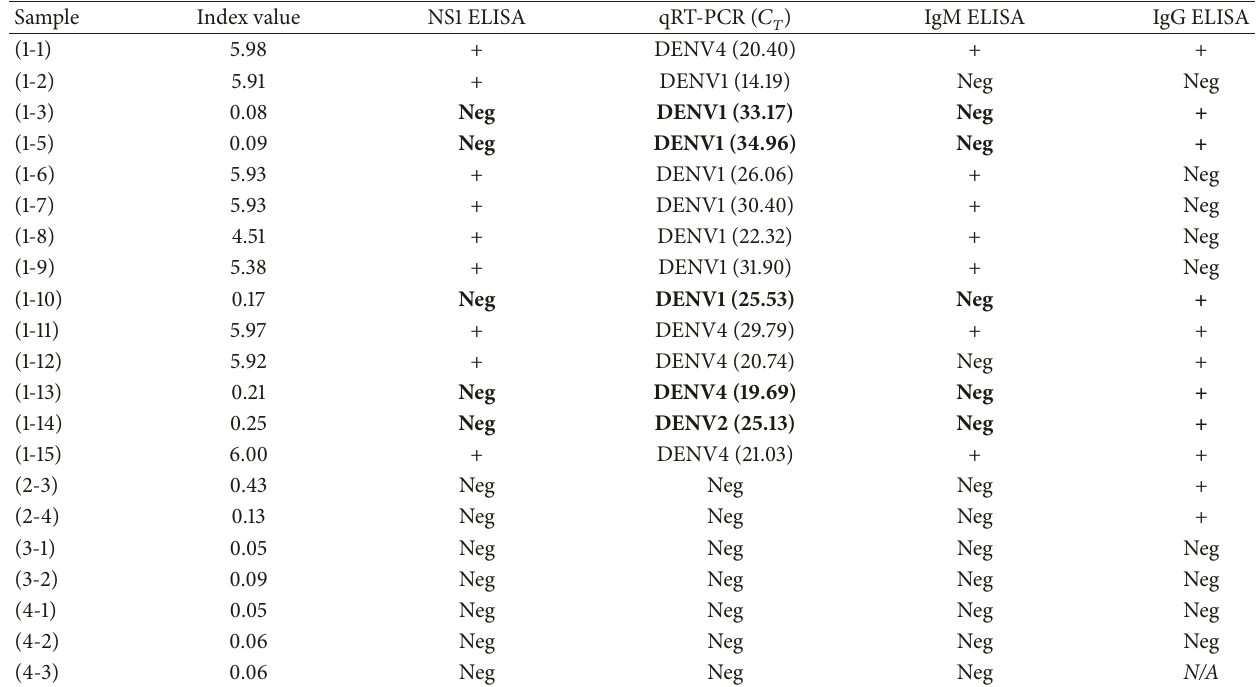
Table 1: DENV NS1 detection in selected serum samples as determined by ELISA and in comparison to clinical molecular (qRT-PCR) and serological (anti-DENV IgM and IgG) results. The table details the results of DENV NS1 detection by ELISA against qRT-PCR, IgM, and IgG DENV assays for a group of serum samples selected for inclusion and based on the following criteria: ( 1 ) denotes samples that were positive by qRT-PCR for DENV as determined by BOPHL-Tampa; ( 2 ) denotes samples that were positive for DENV by IgG detection only as determined by BOPHL-Tampa; ( 3 ) denotes samples that were DENV negative received by BOPHL-Tampa for all DENV-specific assays; ( 4 ) denotes samples that were collected from Martin County serosurvey and were found to be DENV negative by all DENV-specific assays. Index values represent the mean of duplicate values obtained when reading samples at 450 nm and taking calibrators into account. Negative samples had an index value of less than 0.9, those between 0.9 and 1.1 were equivocal, and those above 1.1 were positive for NS1 detection. Results are listed as either positive (+) or negative (neg) for each ELISA. Positive qRT-PCR results are reported either as neg or positive by listing serotype and C value results. Samples that were qRT-PCR+ but NS1 neg are highlighted in bold font within the table. Note that no T single assay here was capable of diagnosing DENV infection